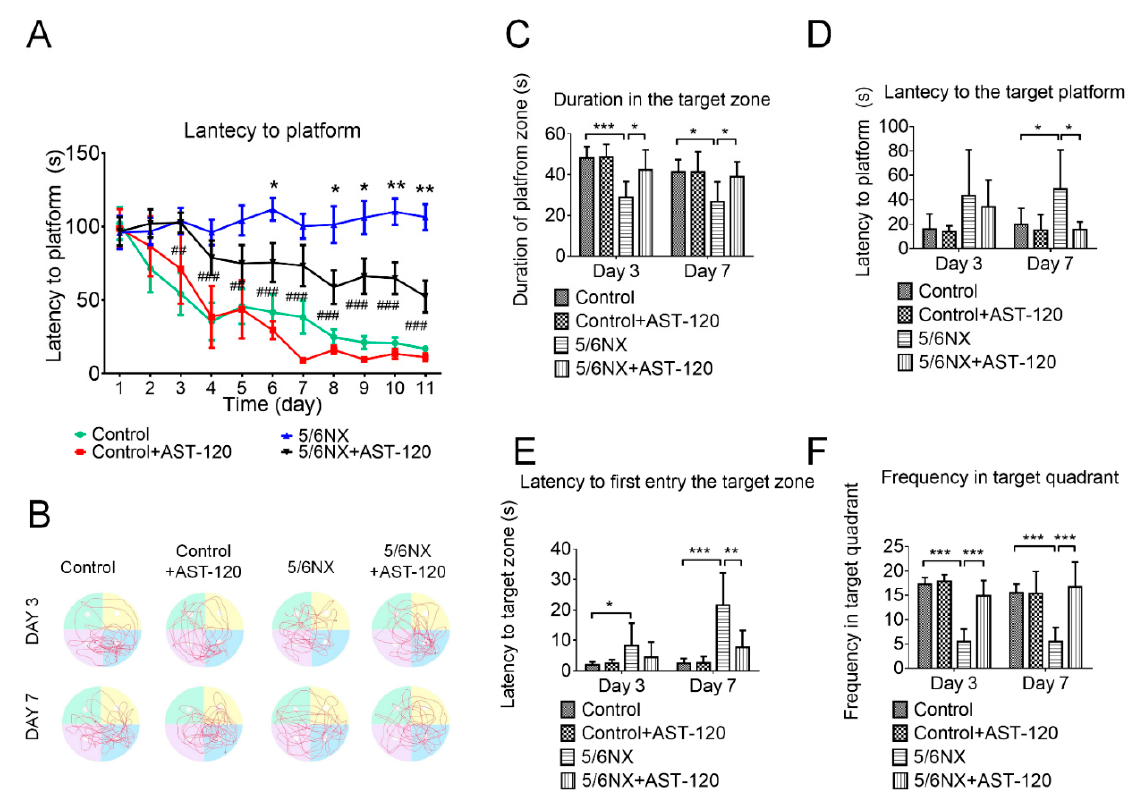
Figure 5. Impaired spatial learning and memory in 5/6 nephrectomy (5/6 NX) mice were prevented by AST-120 administration. Compared with control mice, 5/6 NX mice showed delayed latency in reaching the platform, which was significantly improved in AST-120-treated 5/6 NX mice (panel ( A )). The swimming track during the probe trial at day 3 and day 7 (panel ( B )) was recorded to determine the time duration spent in the platform quadrant, latency in reaching the platform, latency in first reaching the platform quadrant, and frequency of entering the platform quadrant. Compared with control mice, 5/6 NX mice showed a significantly shorter duration in the platform quadrant (panel ( C )), significantly longer latency in first reaching the platform position and quadrant (panel ( D , E )), and a significantly lower frequency of entering the platform quadrant (panel ( F )) on day 3 and day 7, which was indicative of cognitive impairment. However, this impairment of learning and memory abilities was ameliorated by AST-120 administration (* 5/6 NX compared with control, # 5/6NX + 10% AST-120 compared with 5/6NX; * p ≤ 0.1, ** or ## p ≤ 0.01, *** or ### p ≤ 0.00; each group contained 5–10 mice).